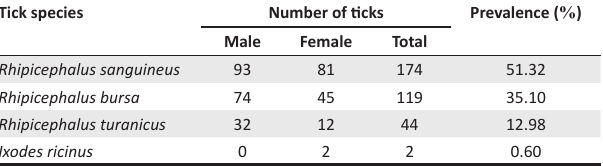
TABLE 2: Number (male and female) and prevalence of various tick species in dogs in the Bejaia province, northeastern Algeria, between March 2016 and February 2017.